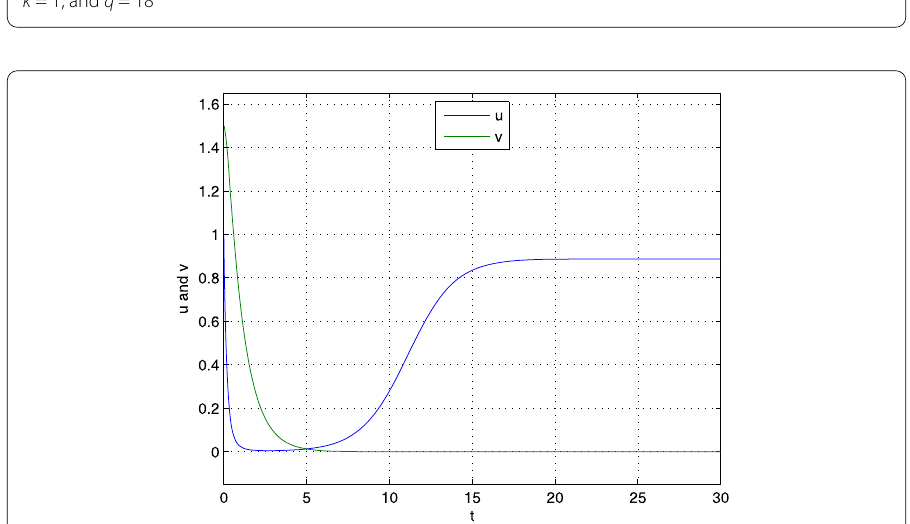
Figure 13 Dynamic behavior of system (1.1) with r 0 = 4, d = 1, a = 1, p = 2, E = 1, m 1 = 1, m 2 = 0.1, c = 0.5, k = 1, and q =